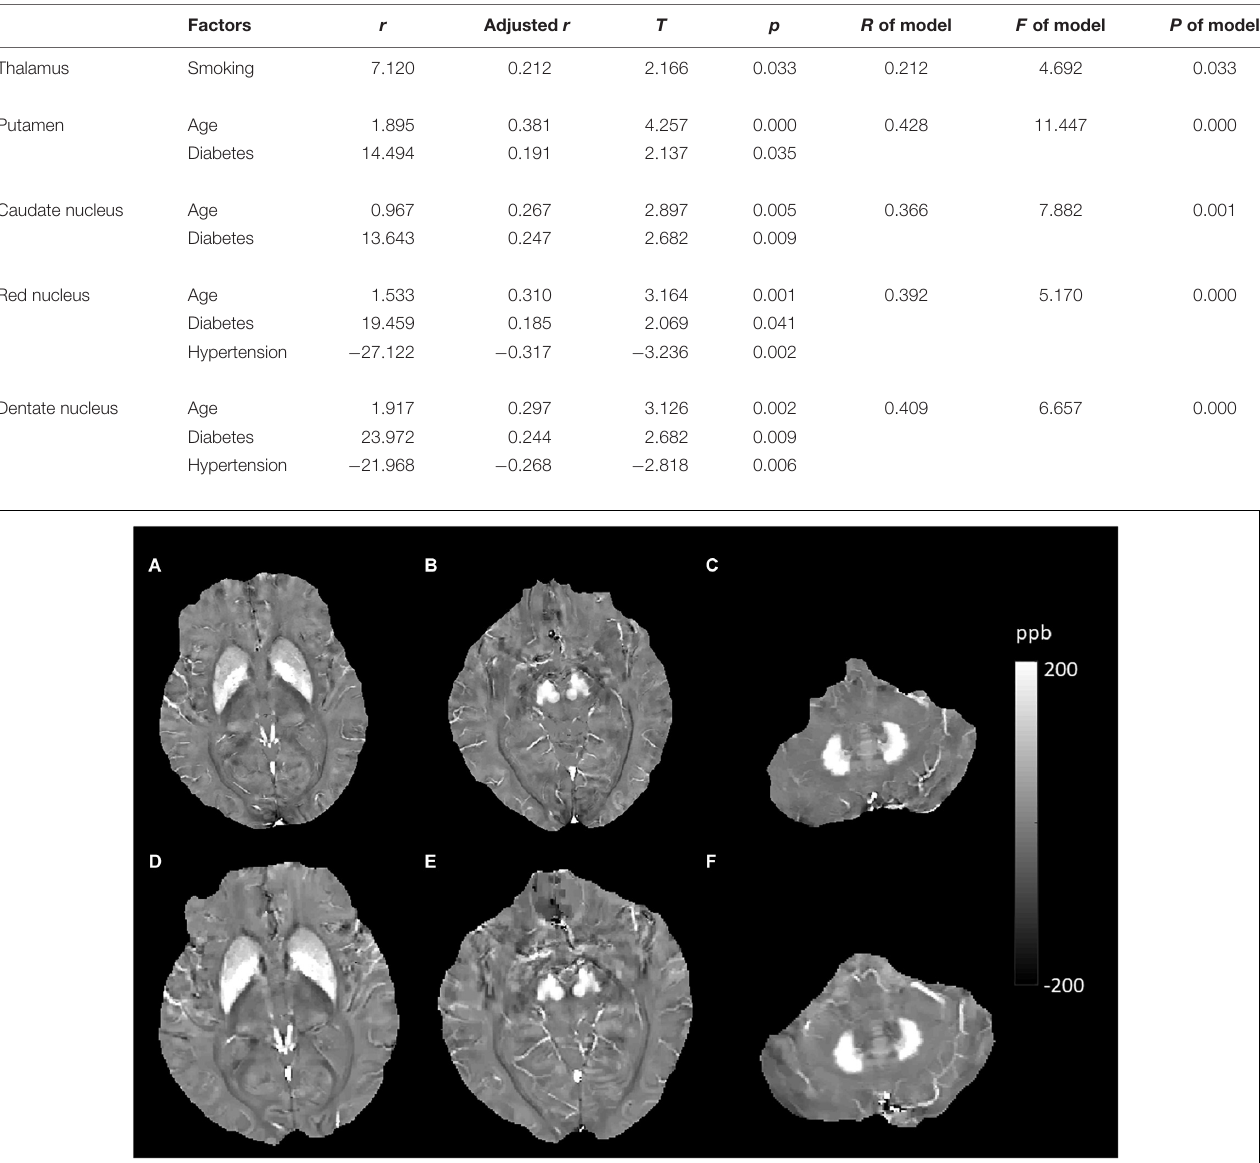
TABLE 5 | Determinants of susceptibility values in gray matter structures: results of multiple linear stepwise regression analysis. Factors